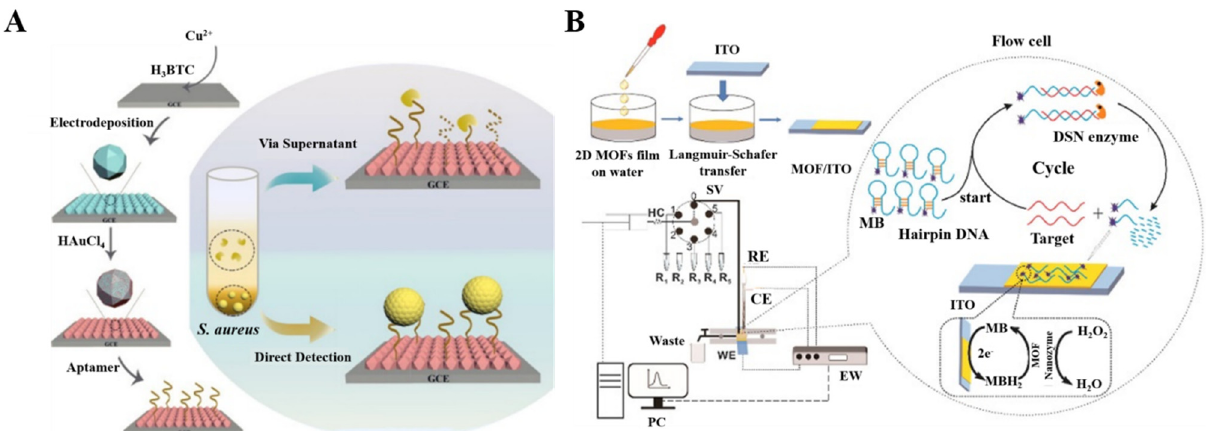
Figure 5. ( A ) Schematic illustration of the fabrication of the DNA/AuNPs/MOFs − based